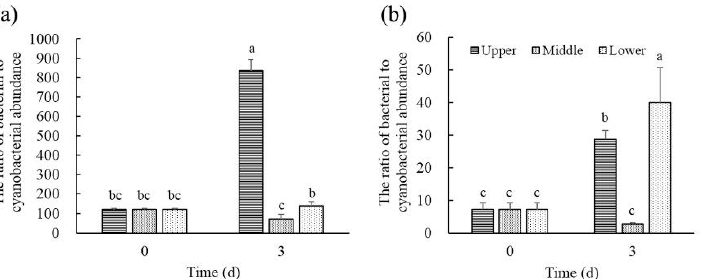
Figure 6. The ratio of bacteria to cyanobacteria in the different layers of water. ( a ) B. diminuta and ( b ) P. stutzeri .